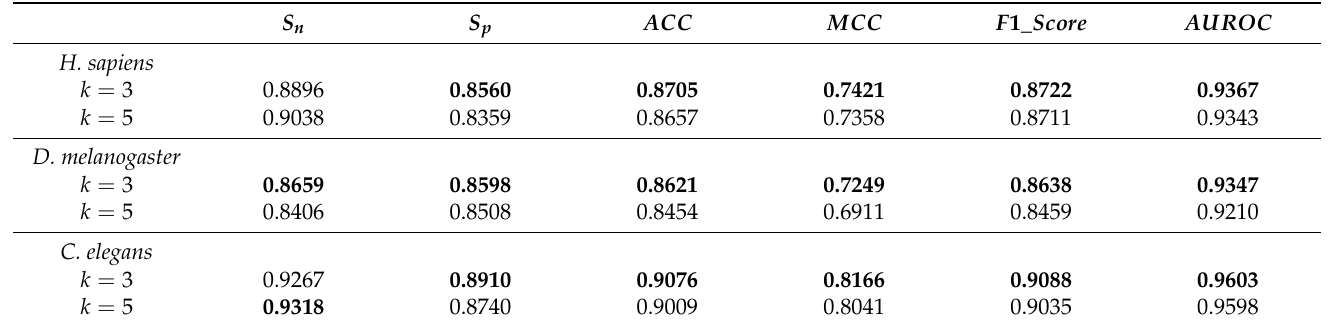
Table 4. Prediction performance of DeepNup in terms of 6 metrics via 10-fold cross validation for 3 species.